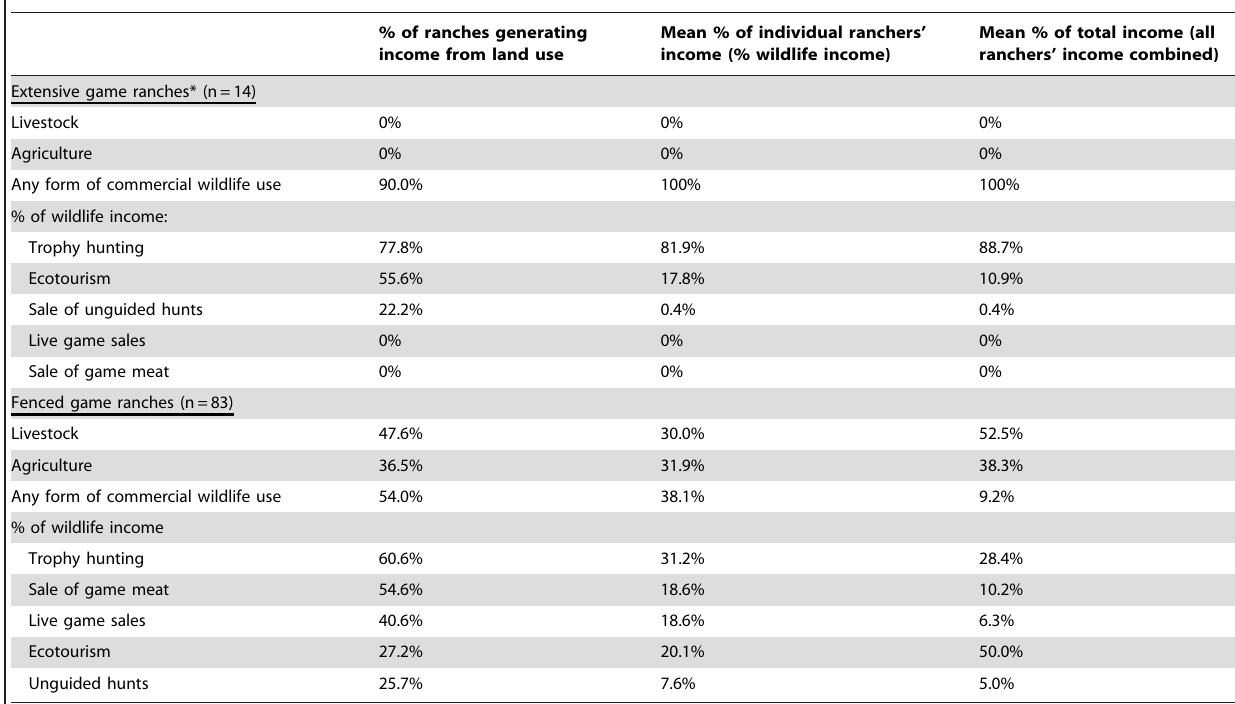
Table 2. Land use and income on extensive and fenced game ranches in Zambia.